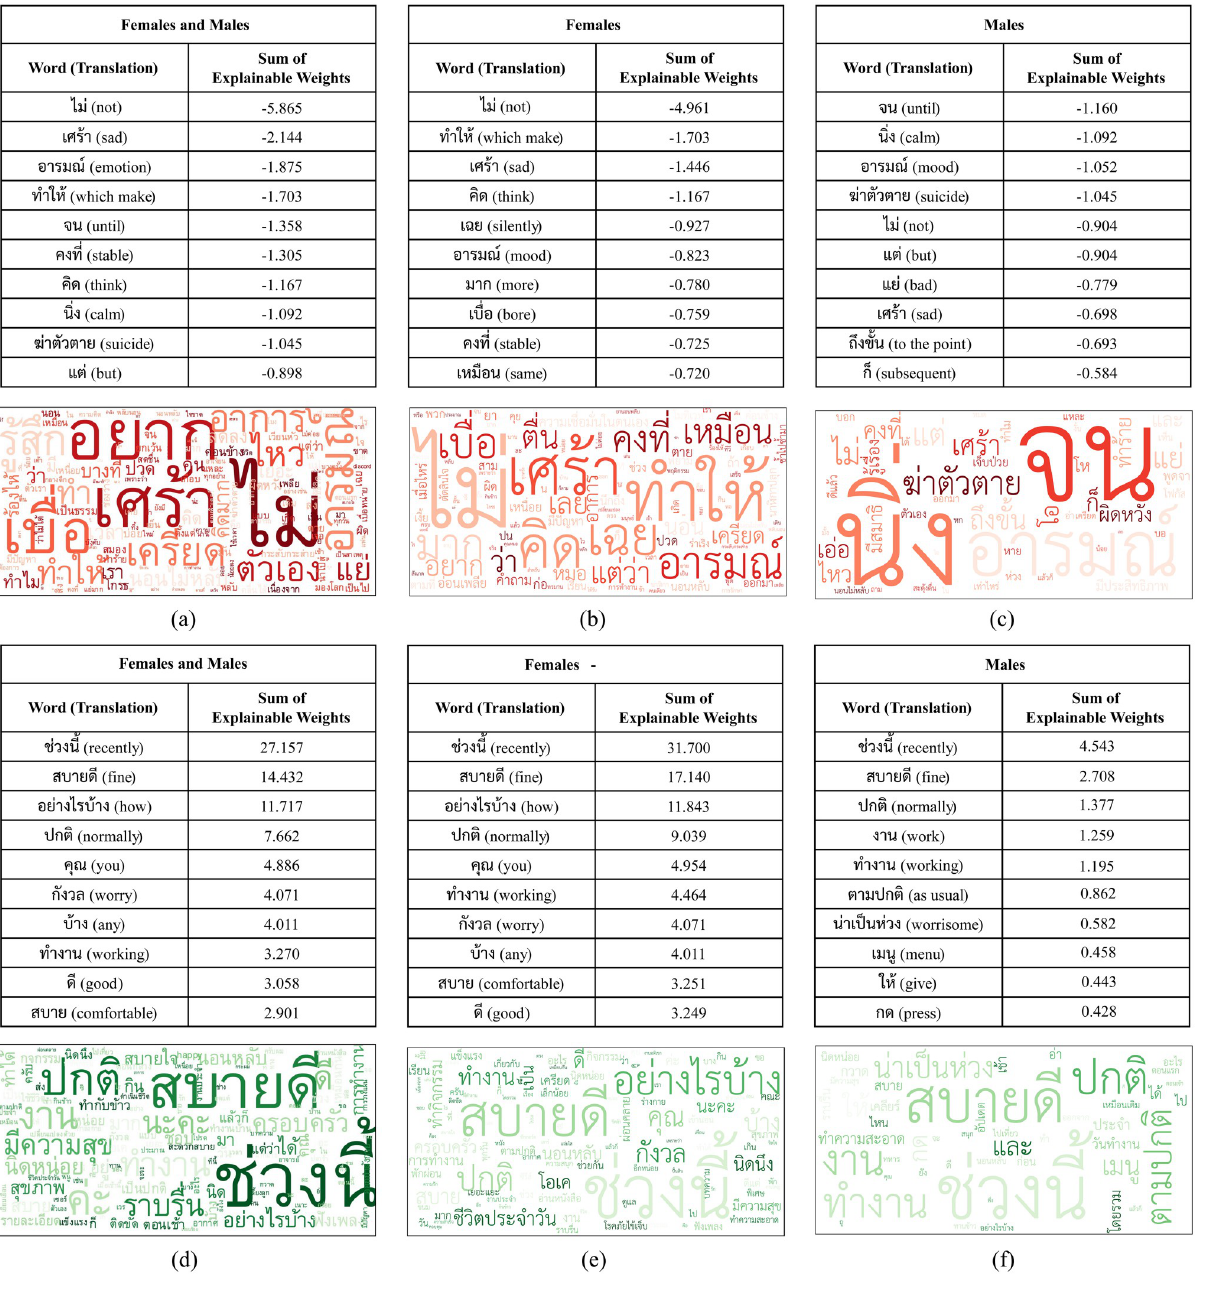
Based on our collected data, which show a prevalence of female and male depression with a ratio of 3:1 and were distributed evenly across severity (as seen in Table 2), the word clouds of Q 1 in Fig 3 produced from depressed females and males (Fig 3b) and 3c)), illustrated some shared words, such as ‘not’, ‘sad’, and ‘mood’, although in different orders. Similarly, a com- parison of the word clouds produced from the normal control females and males (Fig 3e) and